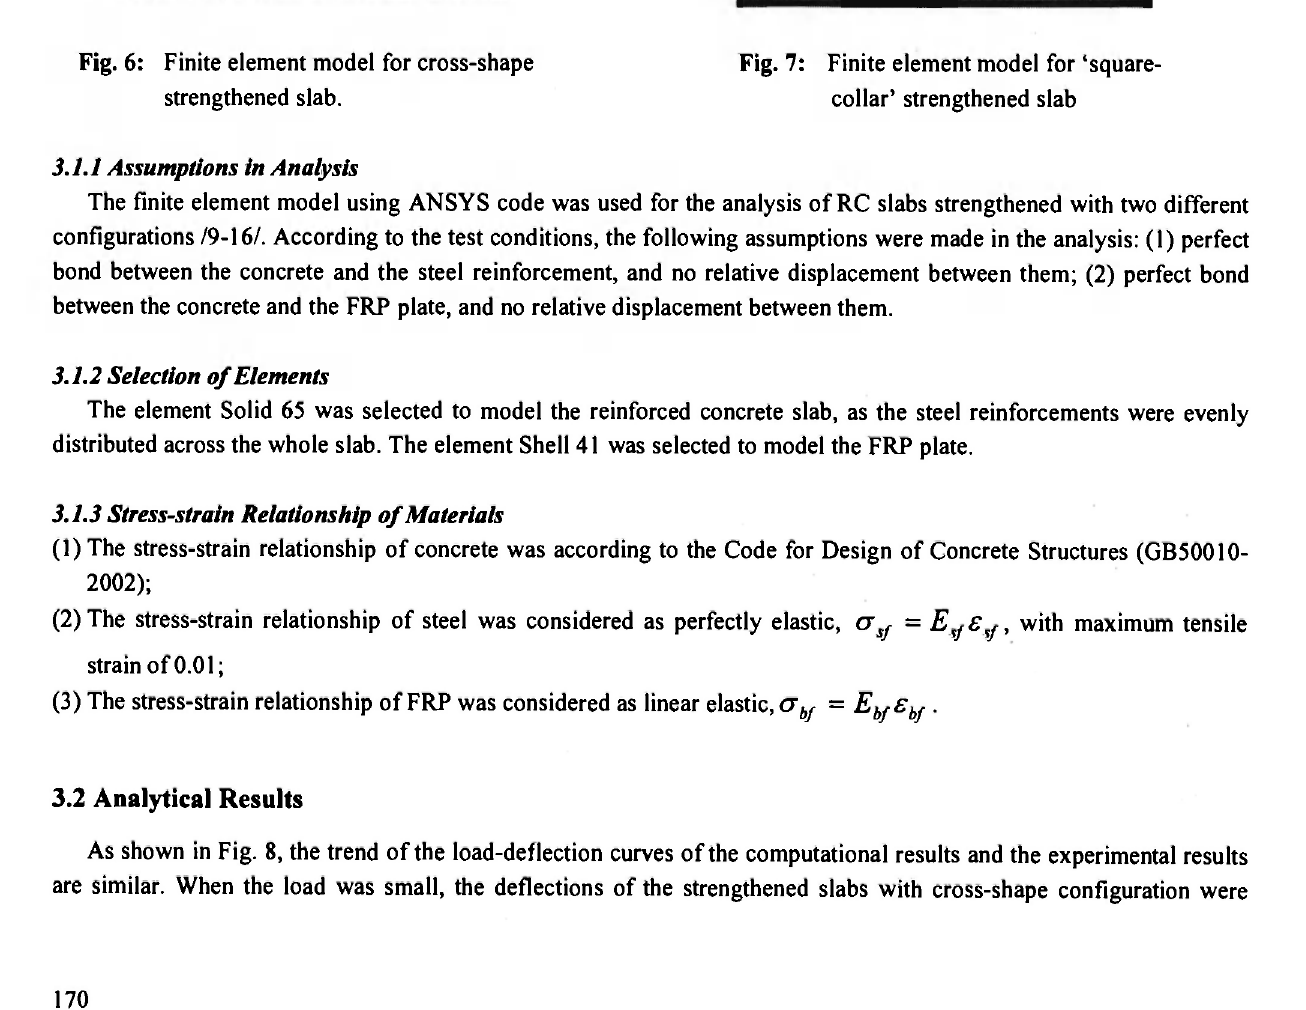
Fig. 6: Finite element model for cross-shape Fig. 7: Finite element model for 'square- strengthened slab. collar' strengthened